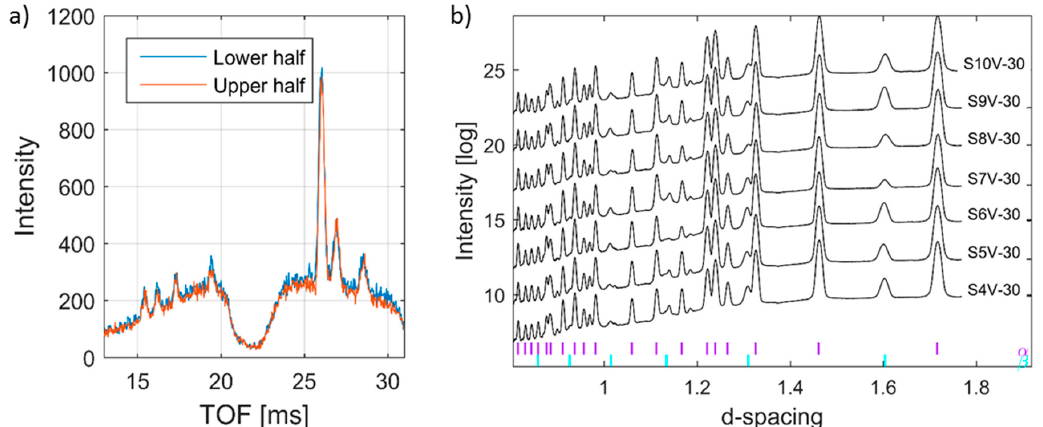
Figure 8. Time ‐ of ‐ flight neutron data for specimen S8 ( a ). Raw diffraction patterns depicting a relative comparison between the upper and lower half of specimen S7, supporting the observations in Figure 6.